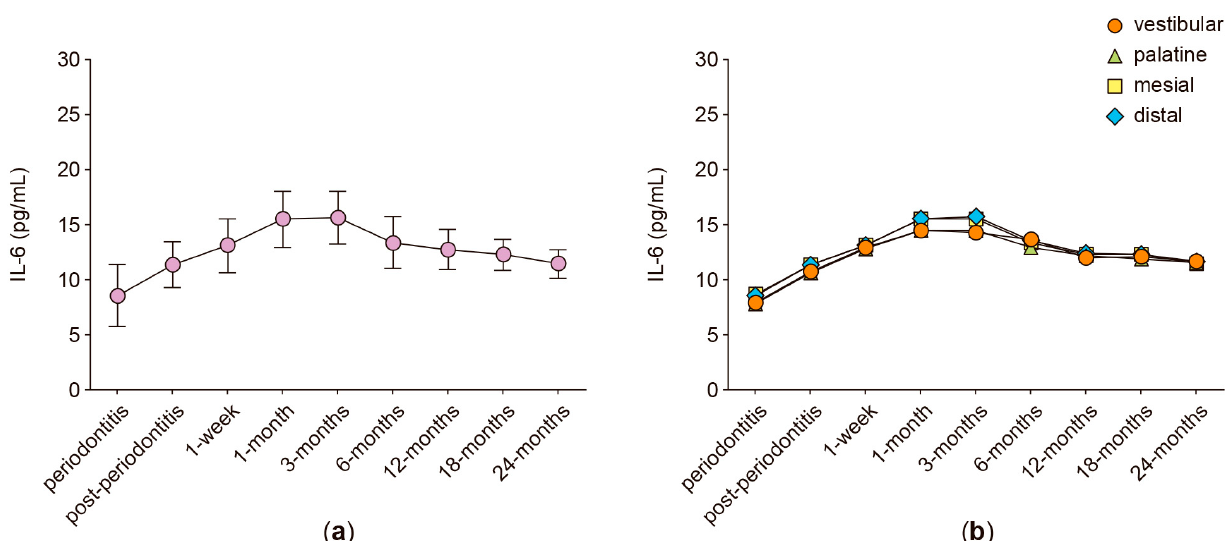
Figure 4. IL-6 levels. ( a ) IL-6 levels detected in the gingival crevicular fluid of periodontally compromised anterior teeth before periodontitis treatment (periodontitis), after periodontitis treatment (post-periodontitis), and during 2 years of patient-specific orthodontic treatment (1 week to 24 months), using intermittent low-intensity orthodontic forces. Data are represented as pg/mL and shown as mean ± SD. ( b ) IL-6 levels detected in each periodontal site, analyzed at the same time-points described in ( a ).